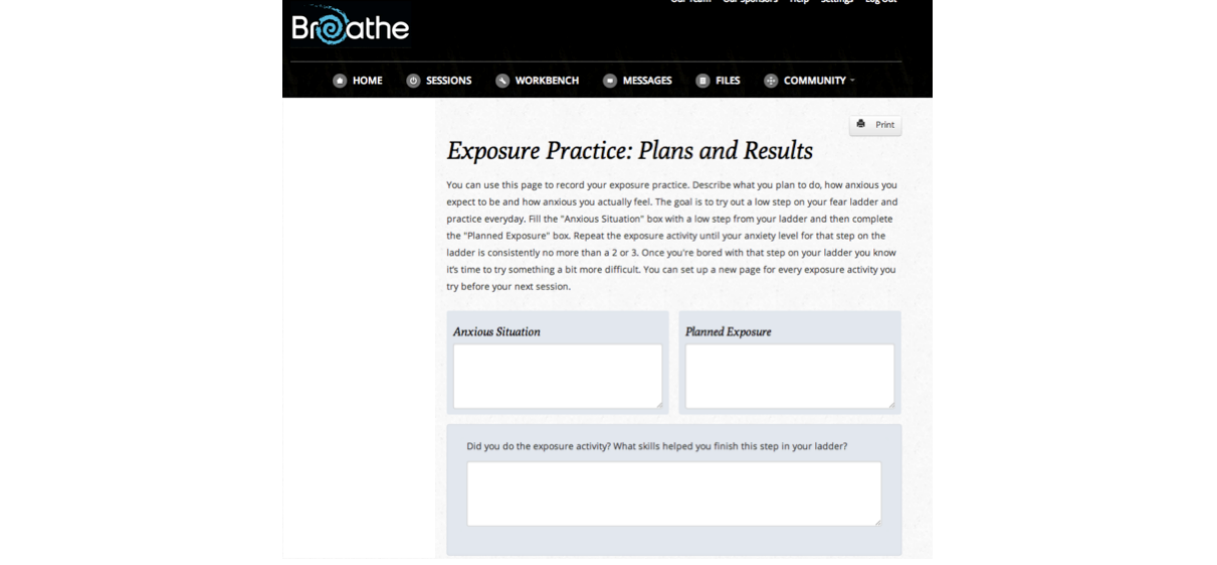
Figure 4. A screenshot of the Try Out activity within the Breathe